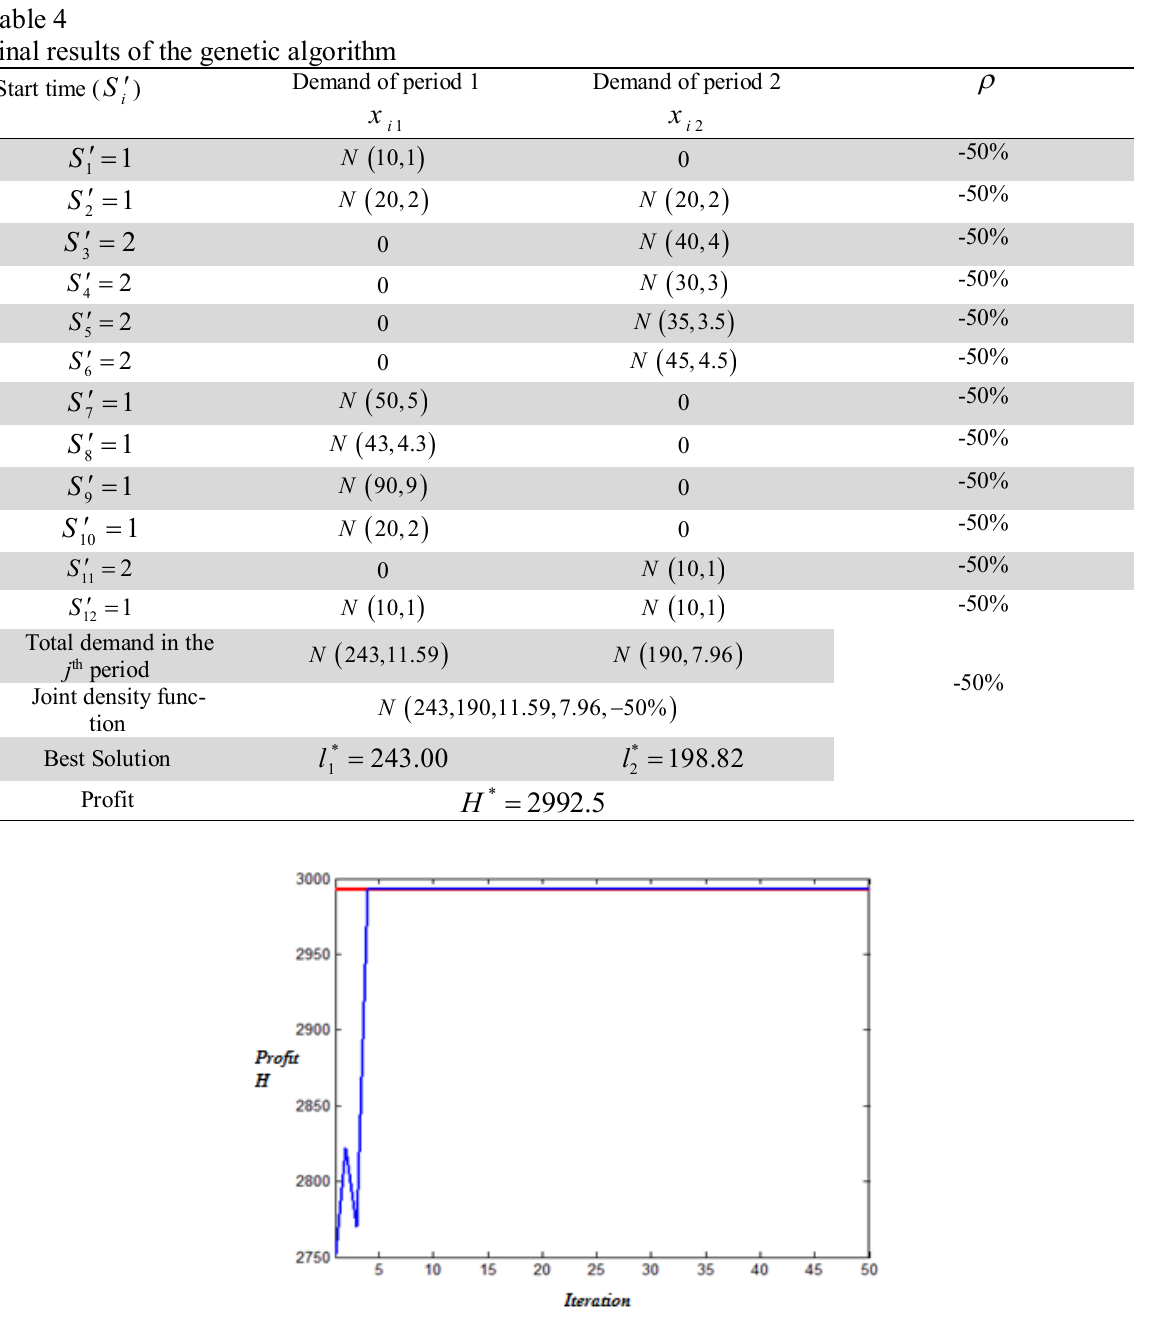
Fig. 4. The final solution of the genetic